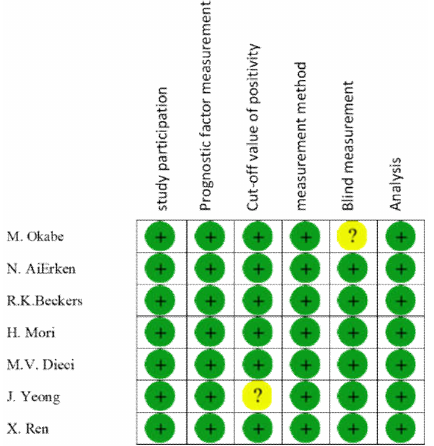
Figure 8. Risk of bias assessment in 7